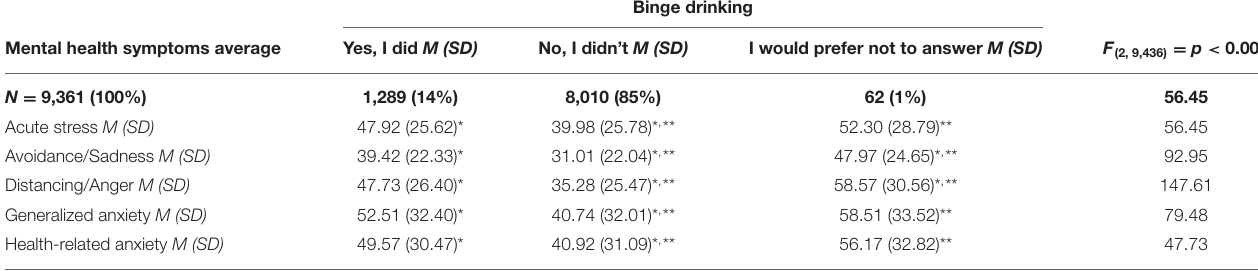
TABLE 3 | Mental health symptom averages regarding binge drinking, and experience of abuse status during the COVID-19 pandemic, and clinical characteristics. Binge